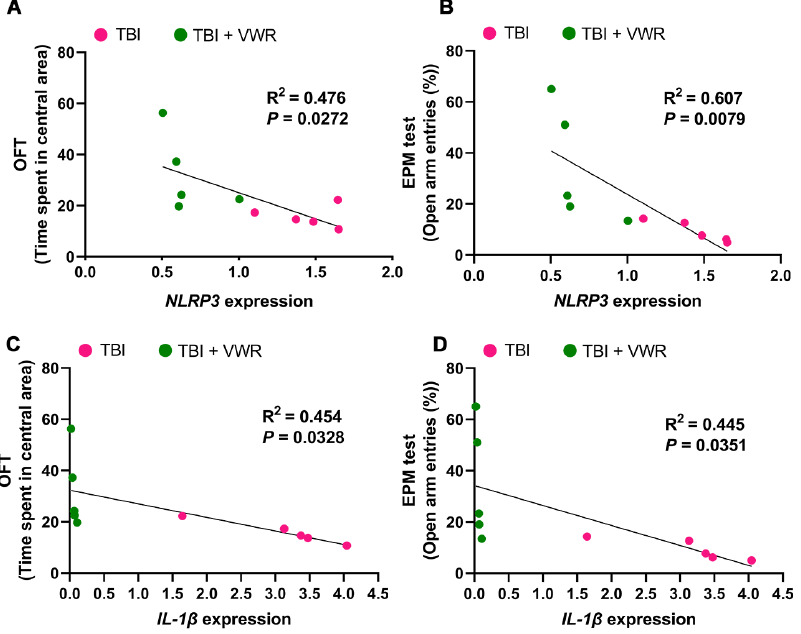
Figure 5. Correlation analysis between anxiety behavior and inflammasome activation. ( A , B ) Positive correlation between reduced NLRP3 mRNA and eased anxiety behavior in OFT and EPM test. ( C , D ) Positive correlation between decreased IL- 1β mRNA and alleviated anxiety behavior in OFT and EPM test. Two-tailed Mann – Whitney U-test, n = 5. NLRP3, NOD-like thermal receptor protein domain associated protein 3; IL- 1β, interleukin 1β ; OFT, open field test; EPM, elevated plus maze.